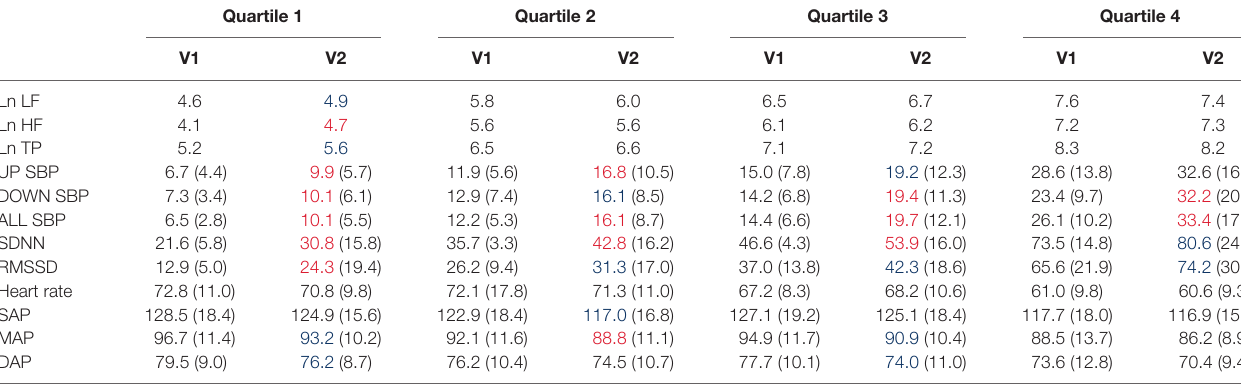
TaBle 2 | Heart rate variability, baroreflex sensitivity, and blood pressure changes by quartile of SDNN. Quartile 1 Quartile 2 Quartile 3 Quartile 4